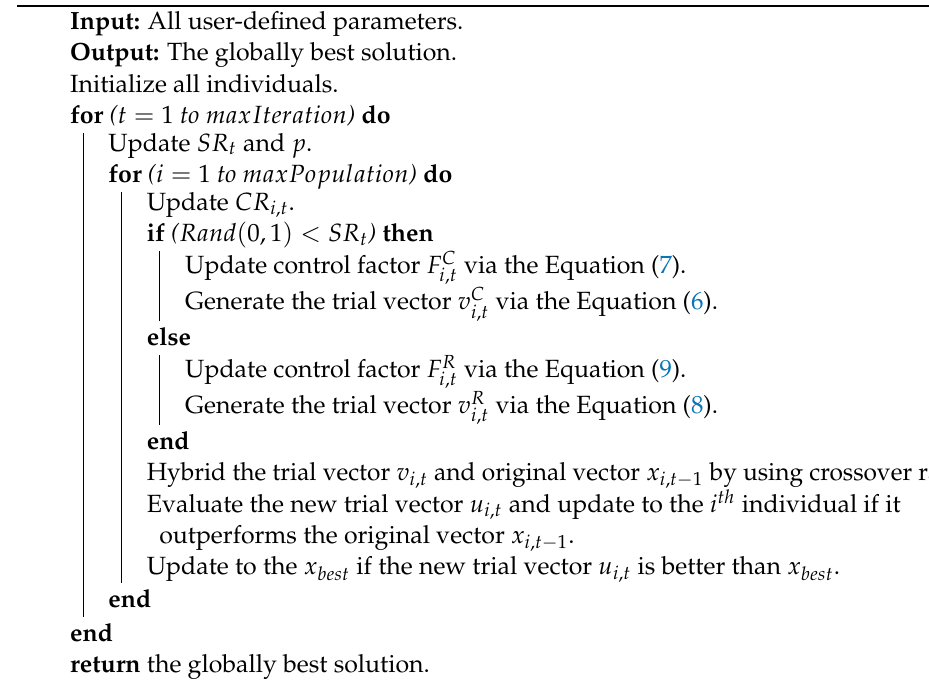
Algorithm 1: The Overall Procedure of the CSDE